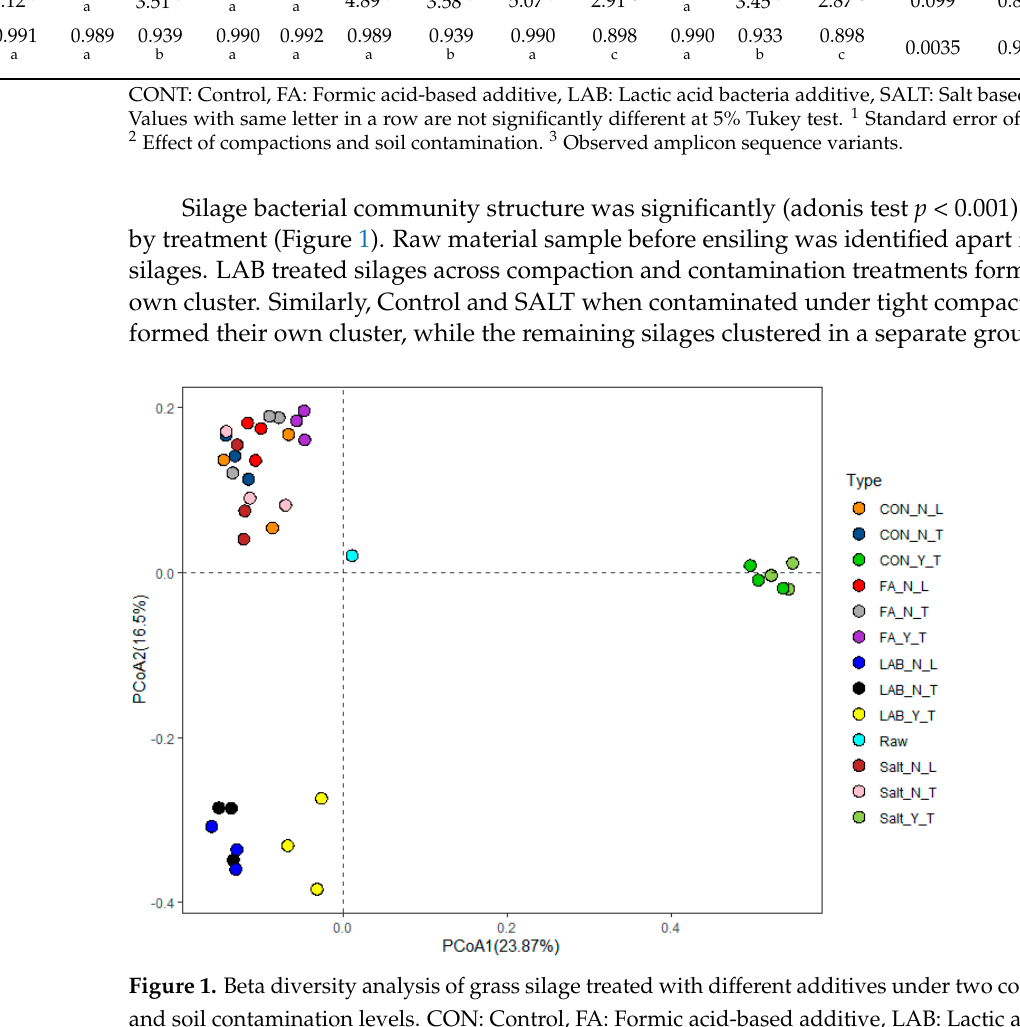
Table 3. Alpha diversity estimates of grass silage treated with different additives under two com- paction (Comp) and soil contamination (Soil) levels.